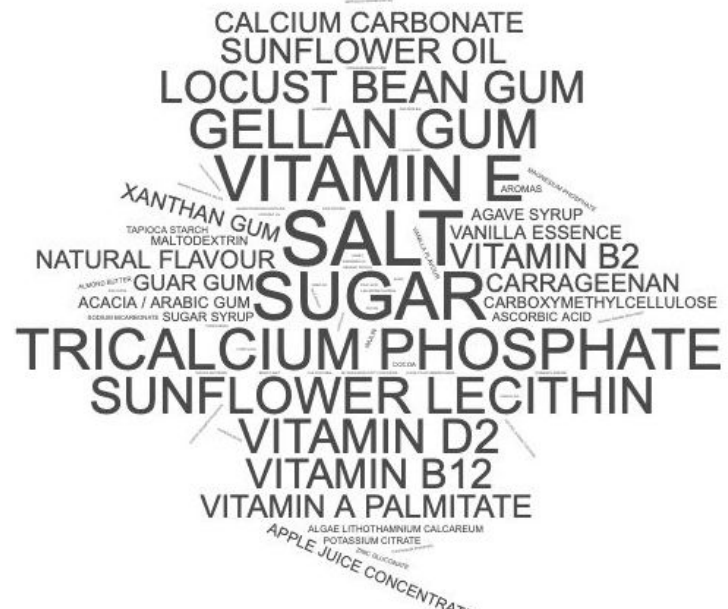
Figure 1. Word cloud of added ingredients from plant-based beverages from scientific studies selected according to the inclusion and exclusion criteria. Words are presented according to their proportional frequencies among all samples, given that greater sizes correspond to greater frequencies.